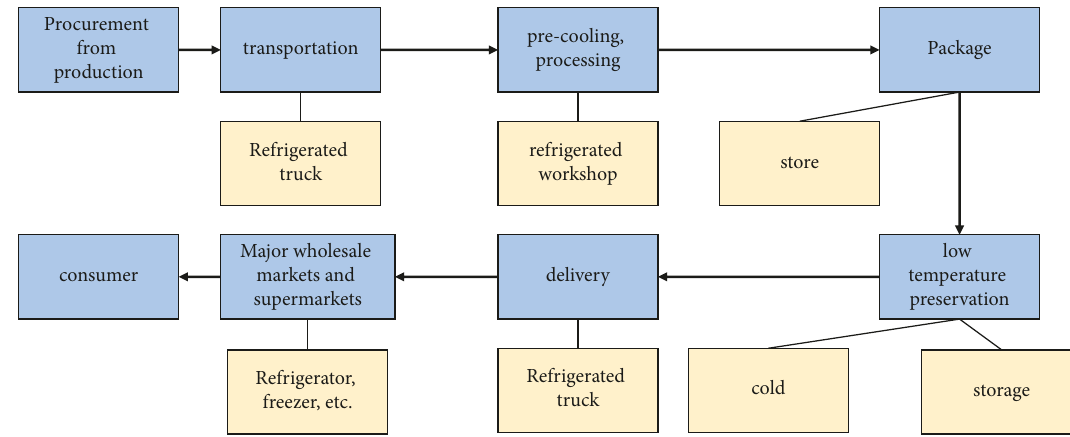
Figure 1: The operation mode of the cold chain service